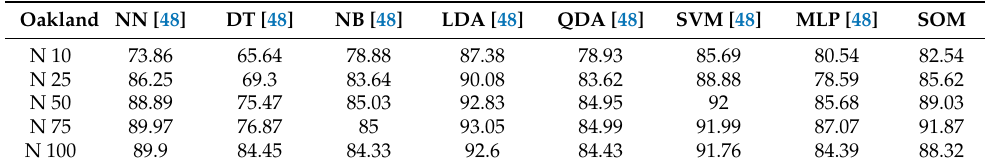
Table 6. Overall accuracy (in %) for different neighborhood definitions and different classifiers.